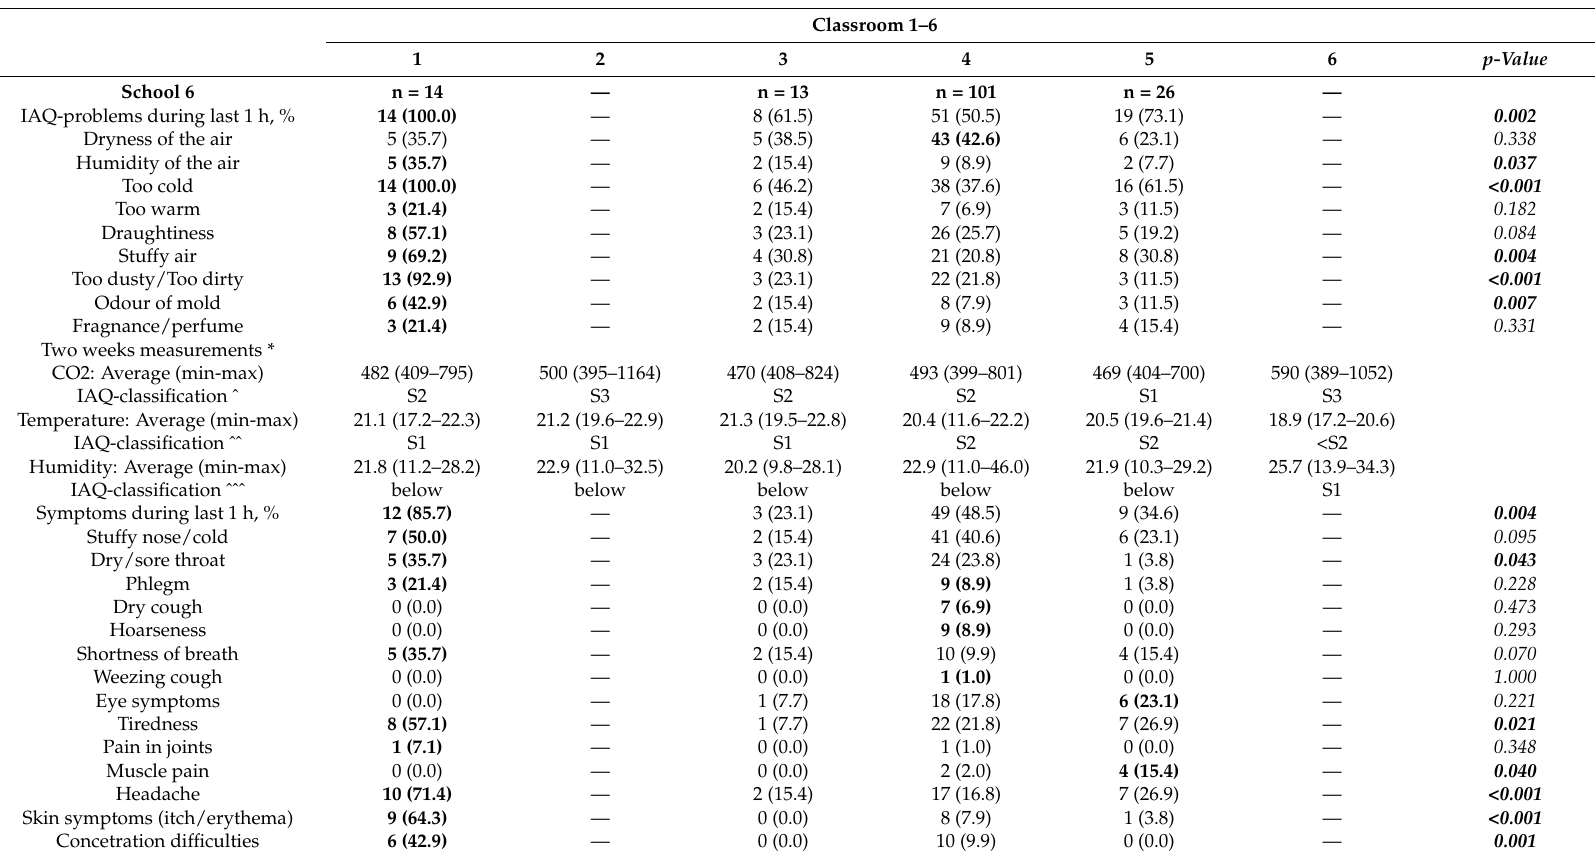
Table 9. Differences between the classrooms in the IAQ problems and symptoms during the last hour among pupils and results of CO 2 , temperature, and relative humidity measurements in school